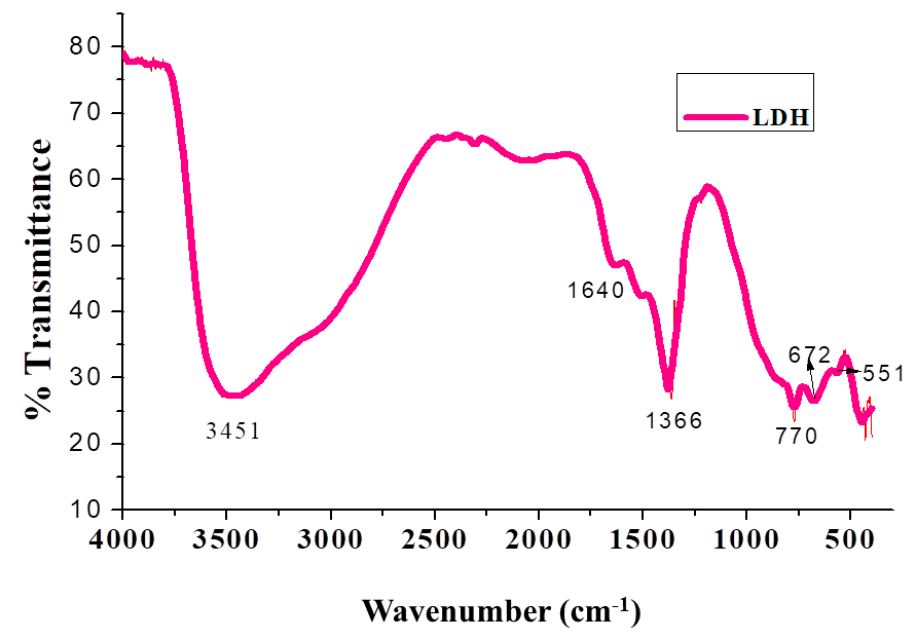
Figure 1. FTIR spectrum of Mg/Al-LDH.